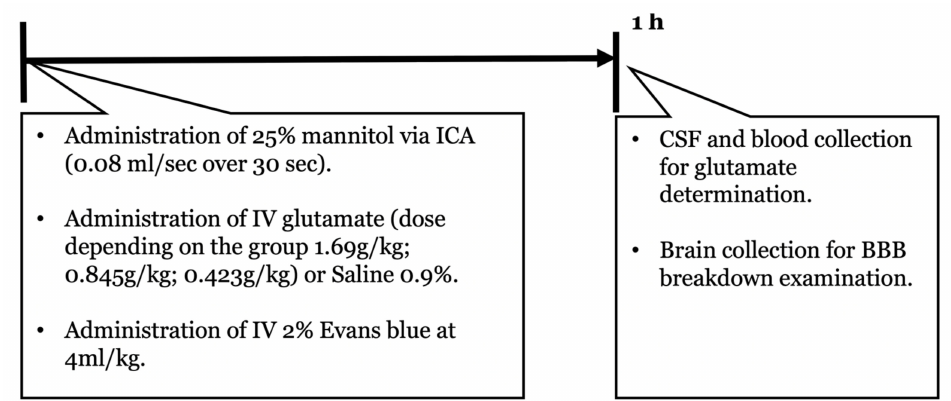
Figure 4. A timeline protocol for hyperosmolar opening of the BBB. Intravenous (IV); internal carotid artery (ICA).